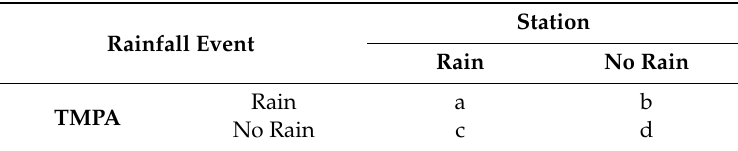
Table 1. Rainfall event